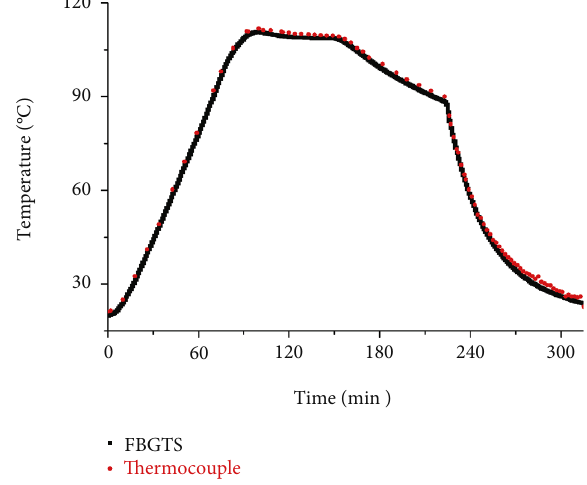
Figure 8: The temperature history during the co-cure bonding process.